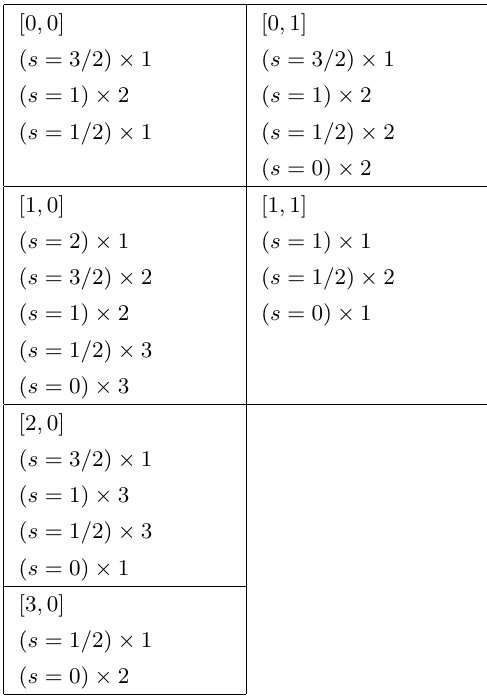
Table 19 . States at KK level n = 1 for the N = 0 G 2 -invariant AdS 4 solution of type